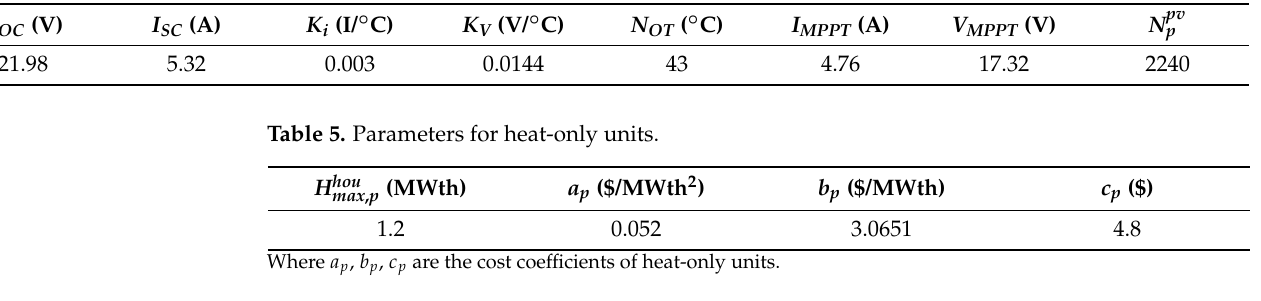
Table 6. Parameters of the CHP